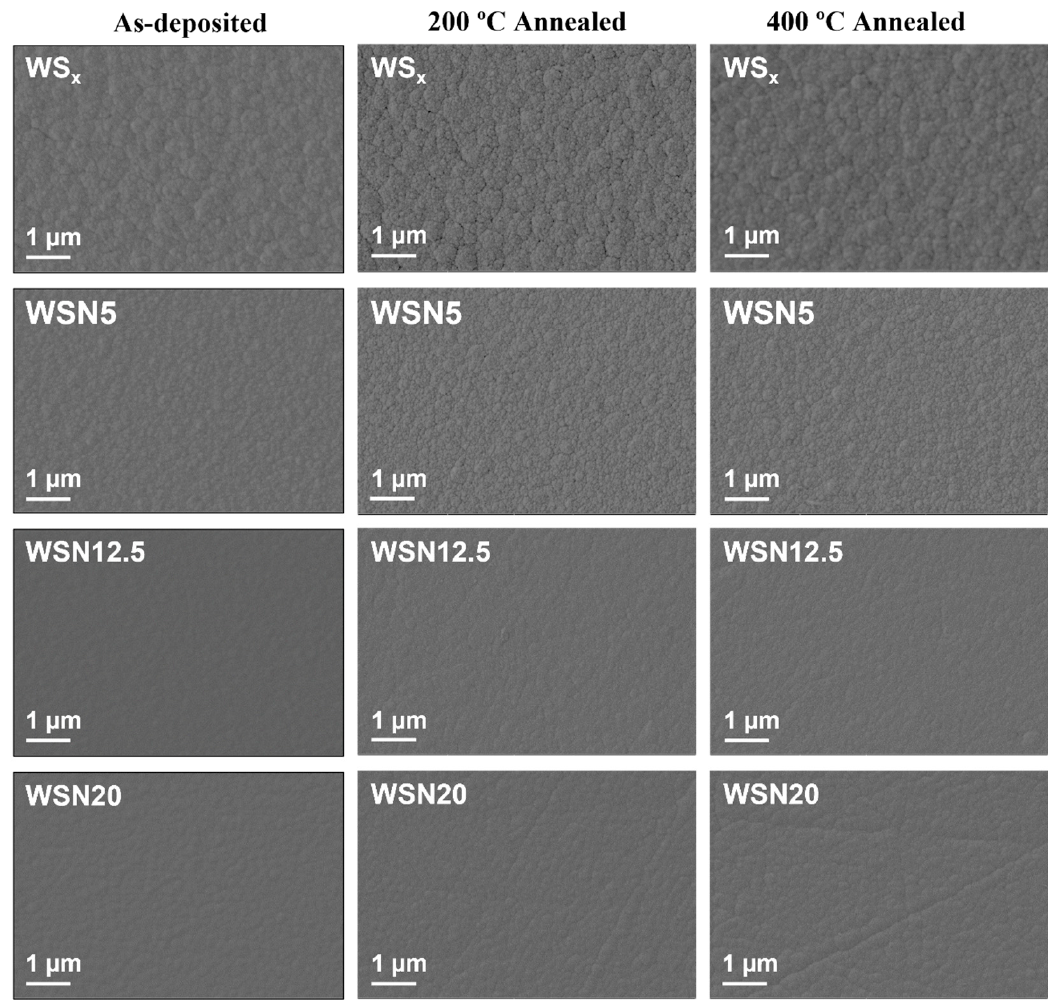
Figure 1. Scanning electron microscopy micrographs showing the surface morphologies of the as-deposited and annealed coatings.